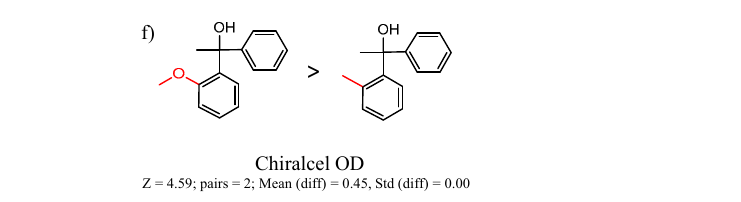
Figure 7. Matched Molecular Pairs illustrating effects of aromatic substituents on chiral recognition.